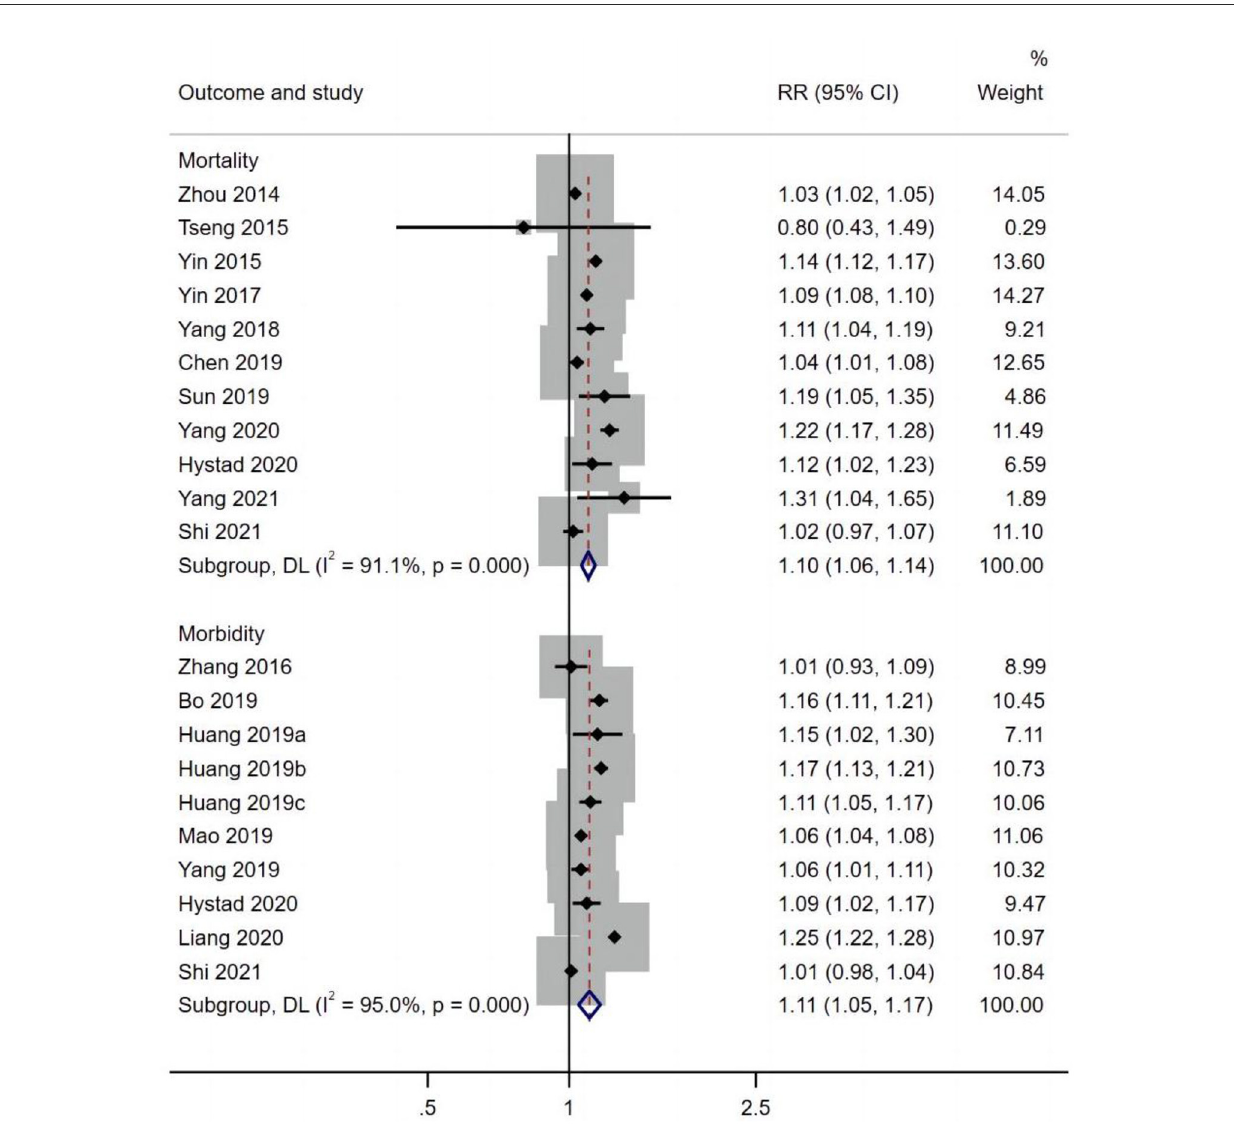
FIGURE2 PM 2.5 effects on cardiovascular disease mortality and